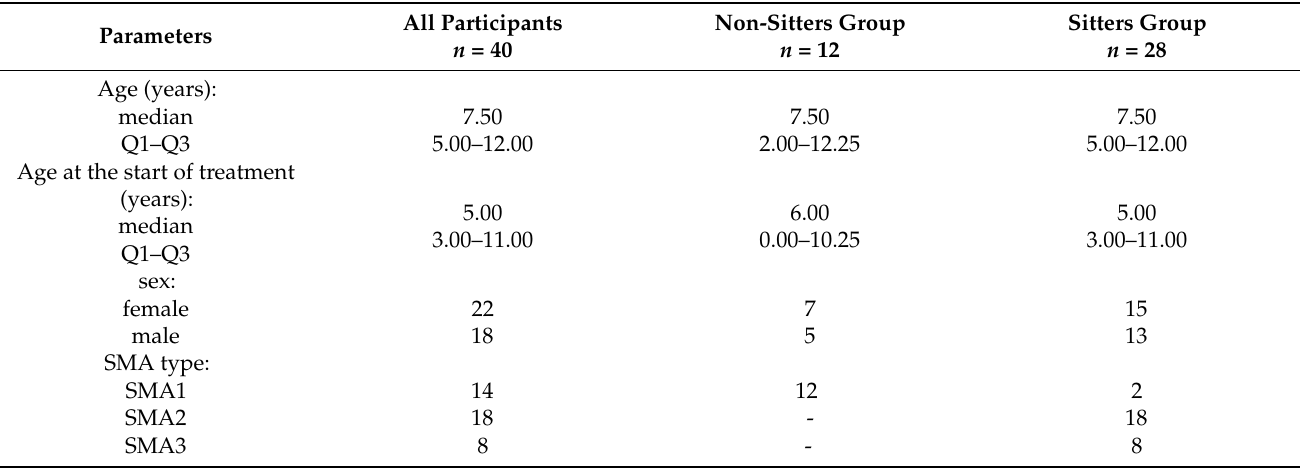
Table 1. Study group